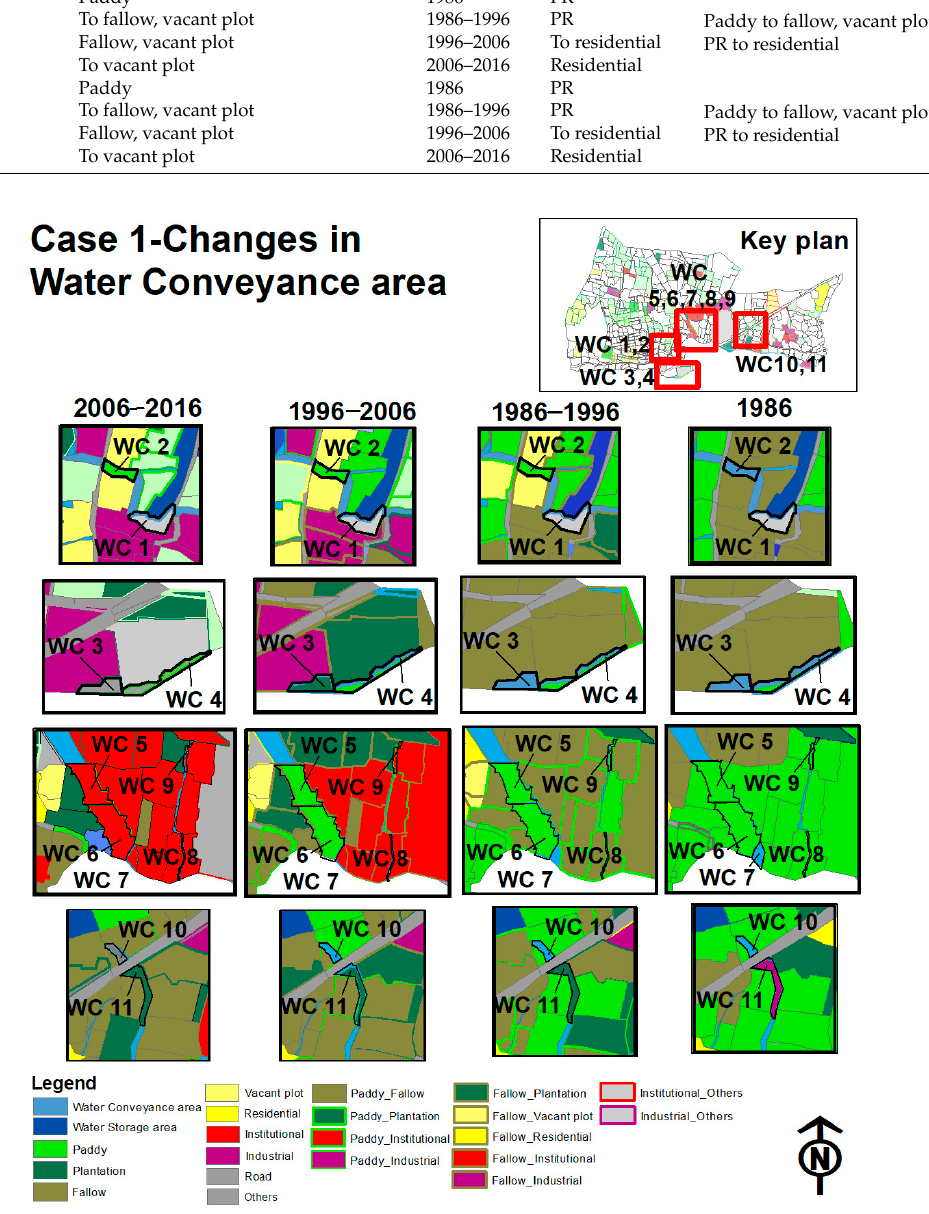
Figure A1. Trajectories of change: Case 1—water conveyance area.